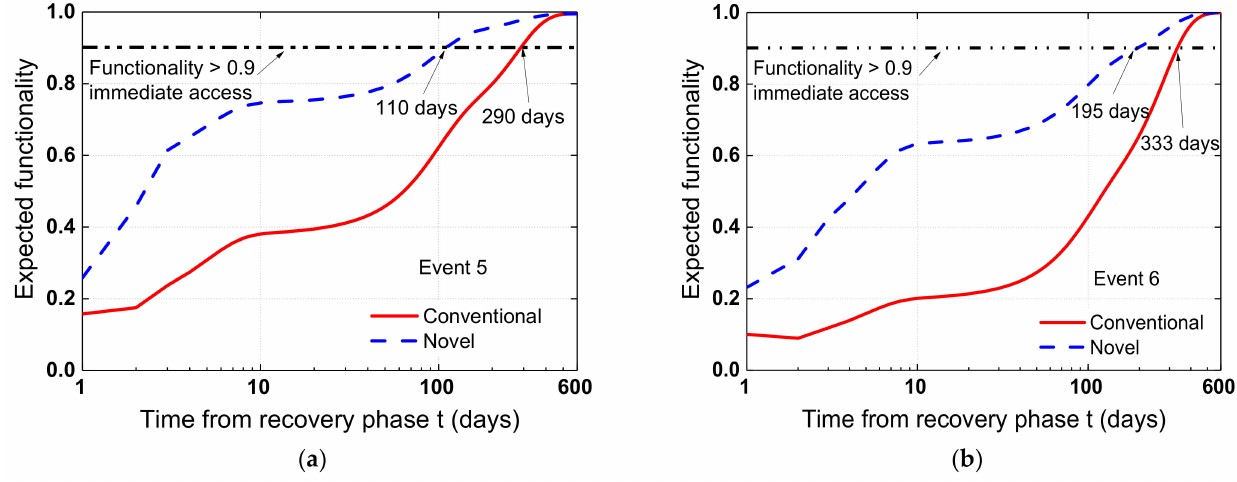
Figure 16. Expected functionality of the bridge from the recovery phase under ( a ) event 5 and ( b ) event